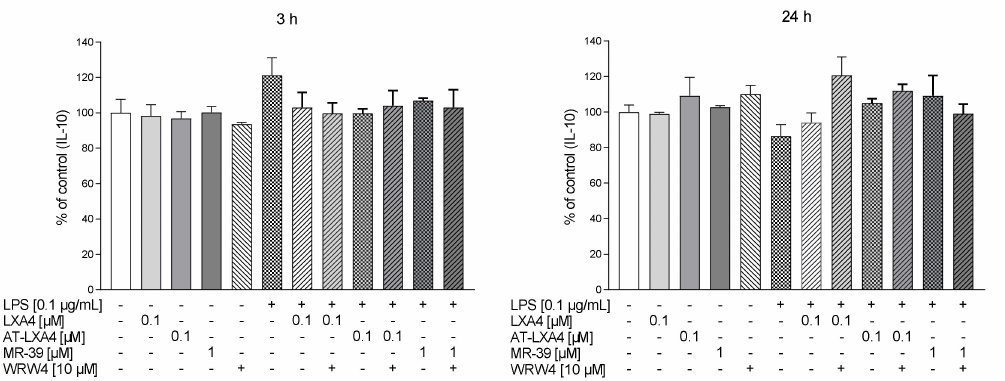
Figure 10. The impact of LXA4, AT-LXA4, and MR-39 on anti-inflammatory cytokines (IL-10) production in rat microglial cultures. The cells were pretreated for 30 min with the FPR2 antagonist WRW4 (10 µ M). After that LXA4 (0.1 µ M), AT-LXA4 (0.1 µ M), or MR-39 (1 µ M) was added for 1 h and then the cells were stimulated for 3 h or 24 h with lipopolysaccharide (LPS; 0.1 µ g/mL). Control cultures were treated with the appropriate vehicle. The data are presented as the mean ± SEM percentage of the control (vehicle-treated cells) of independent experiments, n = 2–5 in each experiment-. LXA4: lipoxin A4; AT-LXA4: aspirin-triggered lipoxin A4; LPS: lipopolysaccharide; IL-10: interleukin